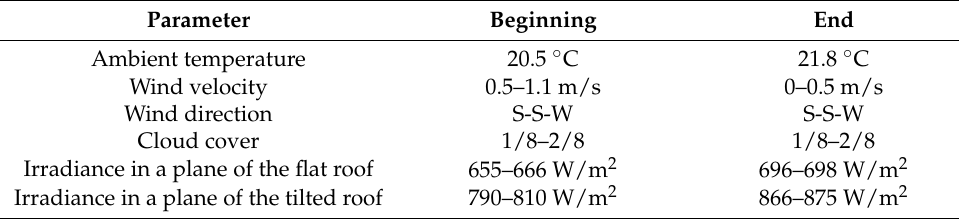
Table 3. Ambient conditions during thermography